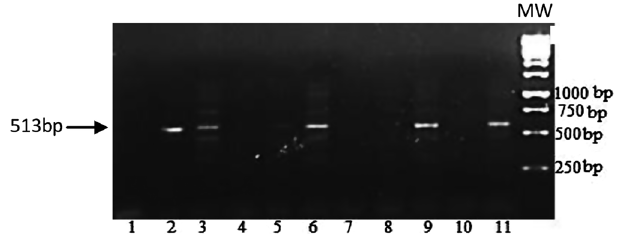
Figure 3. Agarose gel illustrating the DNA pro fi le resulting from the ampli fi cation of a DNA fragment of the Wolbachia surface protein gene using wsp primers. MW: 1 kb DNA ladder molecular weight marker; lane 1: negative control; lane 11: positive control; Lane 2, 3, 6 and 9: samples positive for Wolbachia ; lanes 4, 5, 7, 8 and 10: samples negative for Wolbachia